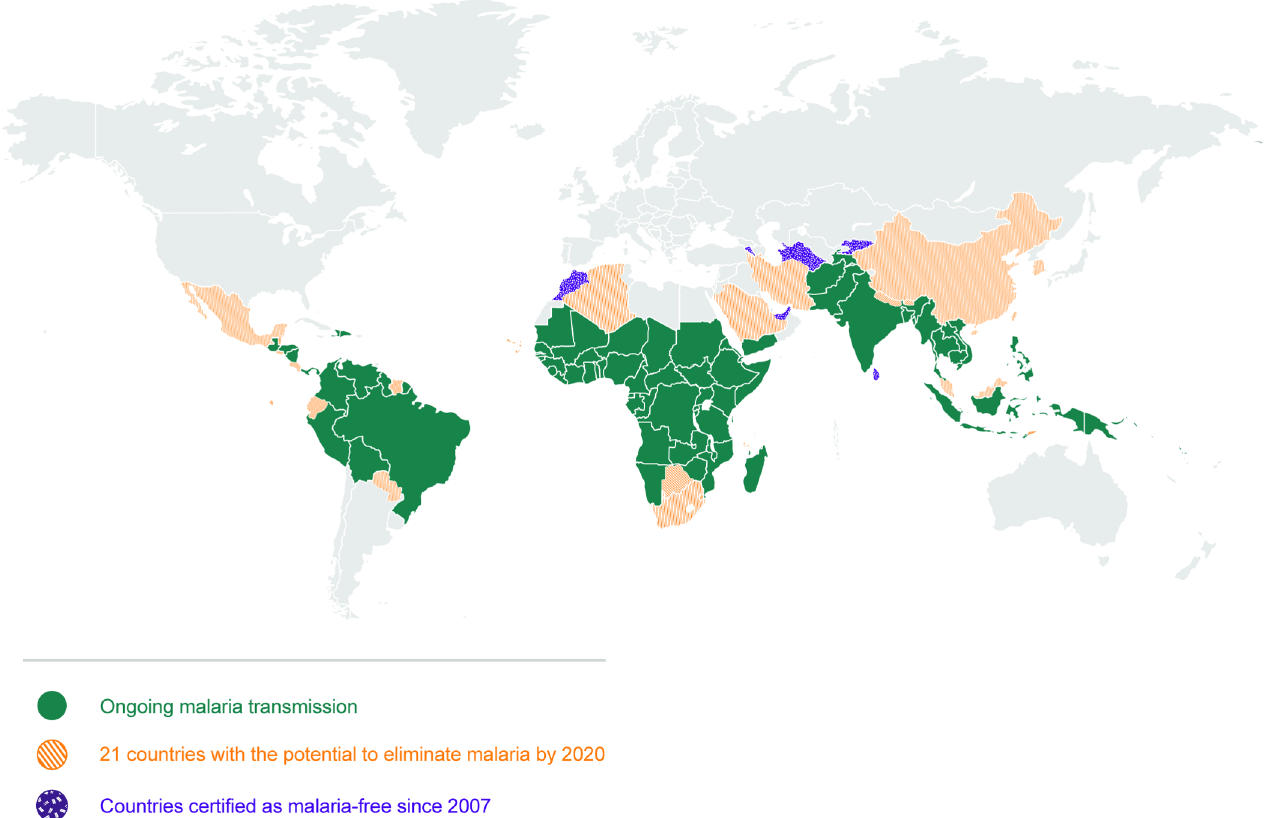
Fig 1. Map of 21 countries with the potential to eliminate malaria by 2020. There are 91 countriesand territories with ongoing malaria transmission [9]. An analysisby WHO has identified21 countries with the potentialto eliminateby 2020: Algeria, Belize, Bhutan, Botswana, Cabo Verde, China, Comoros, Costa Rica, Ecuador, El Salvador, Iran (Islamic Republicof), Malaysia, Mexico, Nepal, Paraguay,Republicof Korea, Saudi Arabia, South Africa, Suriname, Swaziland, and Timor-Leste [10]. Countriesand territories that have been certified malaria-free since 2007 are the United Arab Emirates (2007), Morocco (2010), Turkmenistan(2010), Armenia (2011), Maldives(2015), Sri Lanka(2016), and Kyrgyzstan (2016) [9,10].Argentinaand Paraguayhave formally requestedcertification of malaria elimination and are in the process. Note that not all countries that have achievedzero indigenous cases for 3 consecutive years have sought certification from WHO. Map base vector created by Freepik .